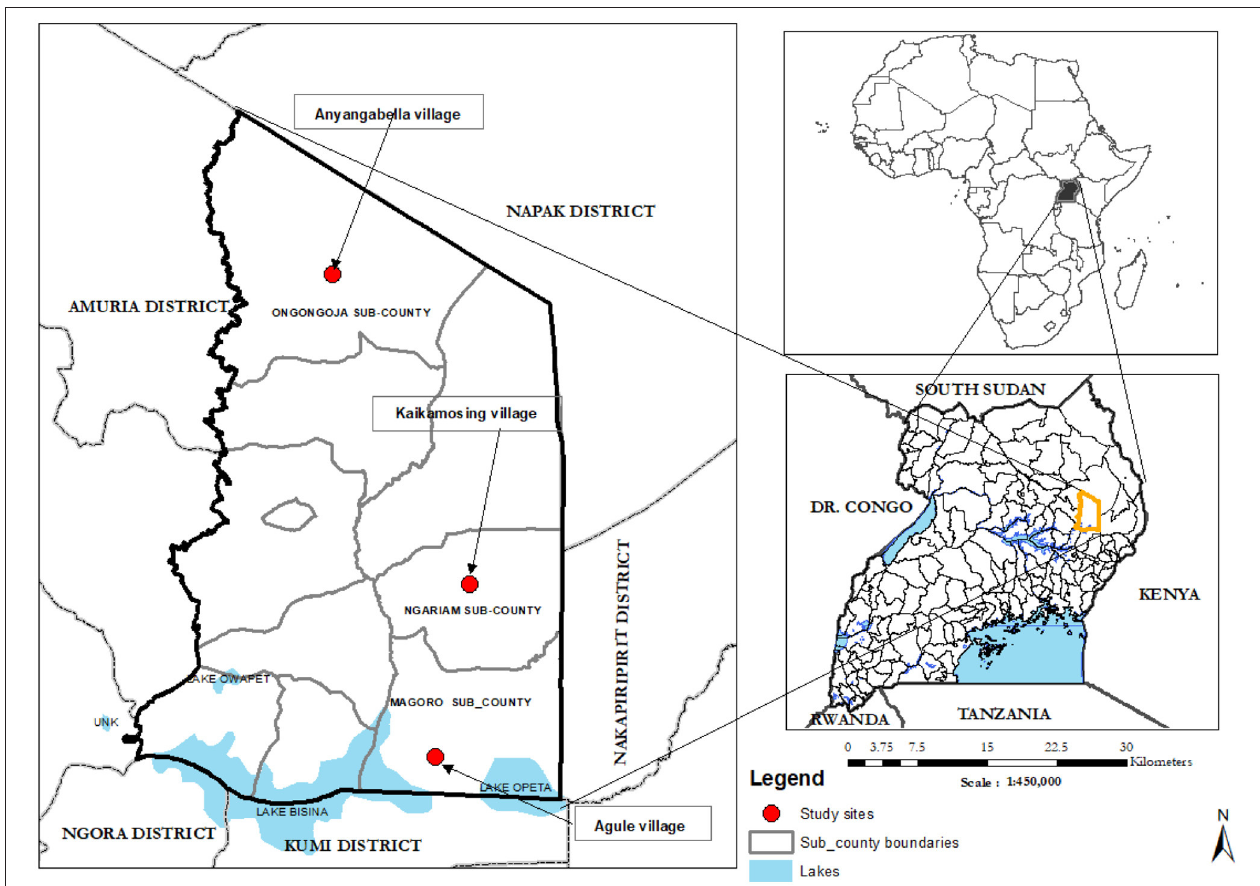
FIGURE 2 | Location of the study sites in Katakwi District, Uganda.